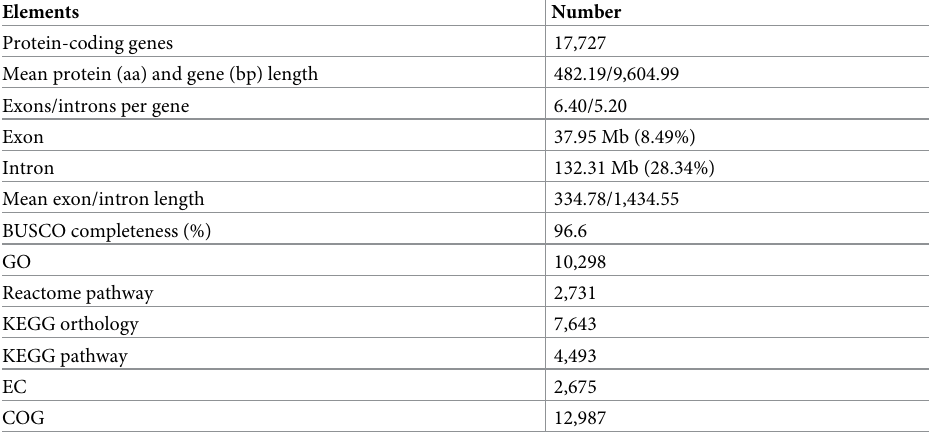
Table 2. Genome annotation statistics of the beet